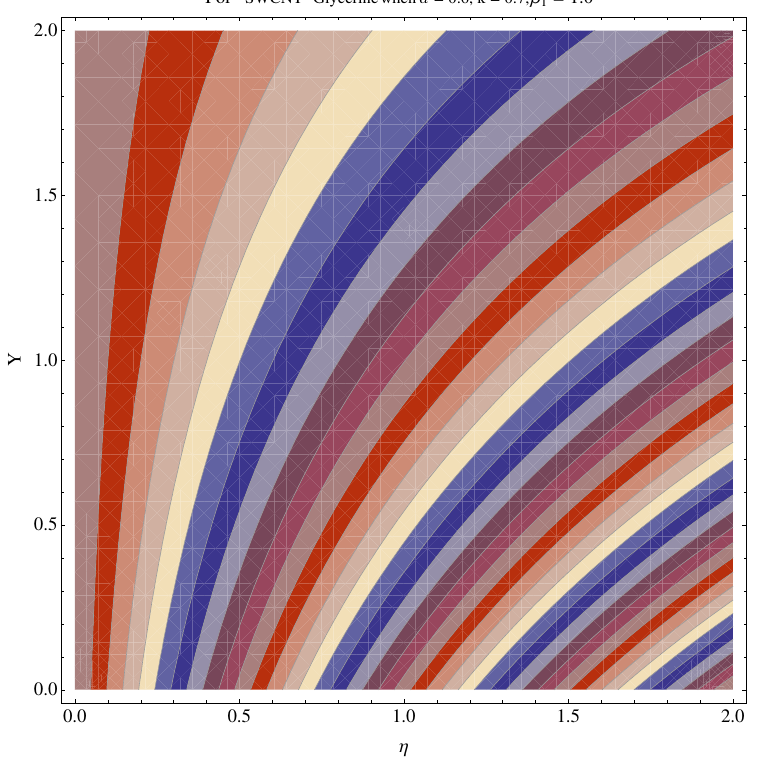
Figure 22. Contour graph at β 1 = 1.0 for MWCNT-Glycerine at larger k